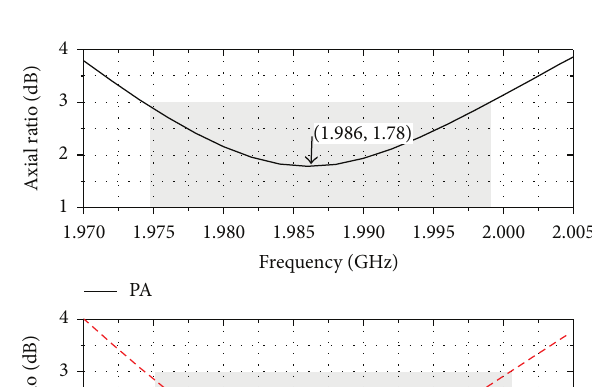
Figure 9: Geometry of PA.